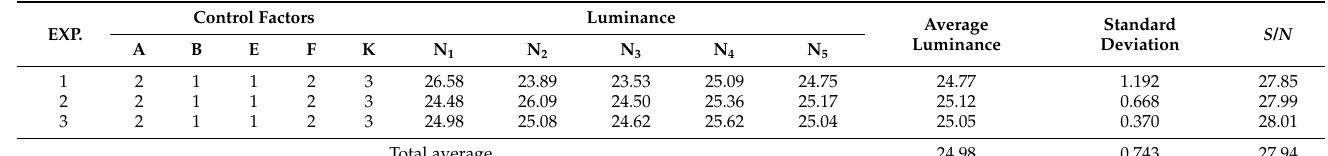
Table 14. Results of the confirmation experiments for the Taguchi Method.